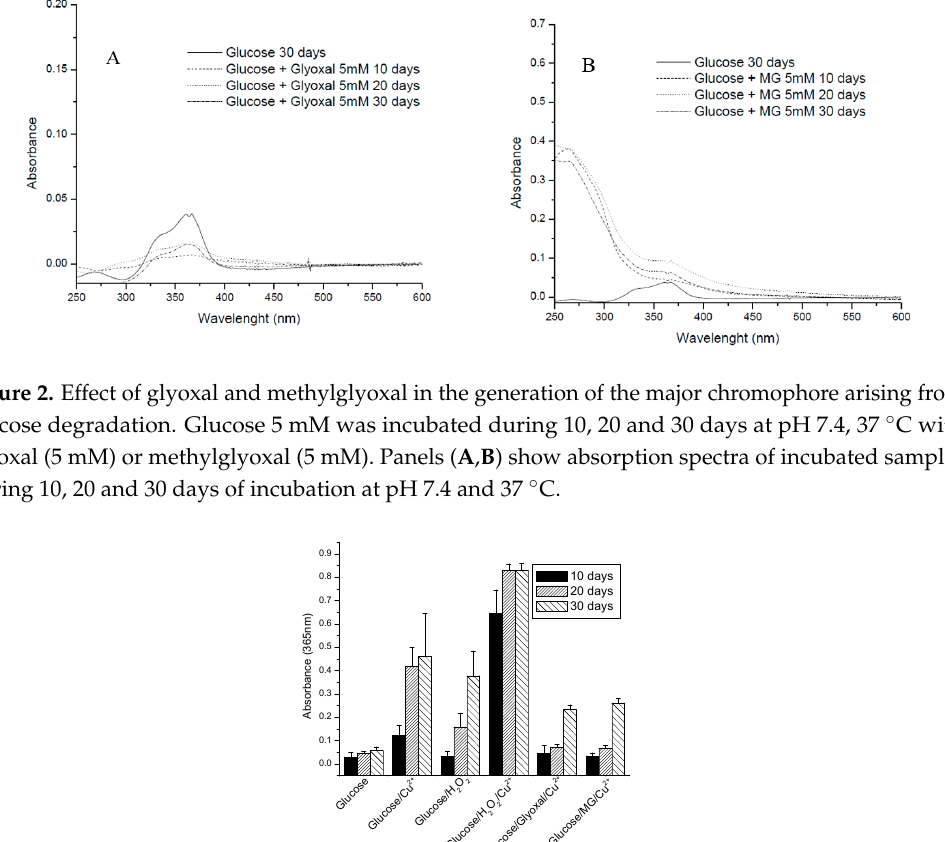
Figure 1. Effect of H 2 O 2 and Cu 2+ in the generation of the major chromophore arising from glucose degradation. Glucose (5 mM) was incubated during 10, 20 and 30 days at pH 7.4, 37 °C with different concentrations of Cu 2+ or H 2 O 2 . Panels ( A , B ) show absorption spectra of incubated samples; Panels ( C , D ) show the absorbance determined at 365 nm, changing the concentration of Cu 2+ or H 2 O 2 ; Panels ( E , F ) show the area under the curve analysis, integrating the absorbance at 365 nm by each concentration along incubation time. Error bars indicate the standard deviation of the mean.